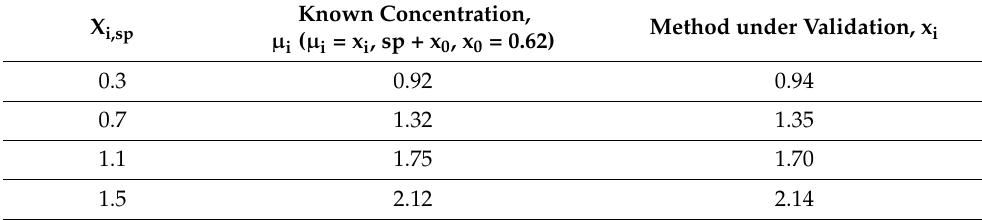
Table 4. Accuracy of the